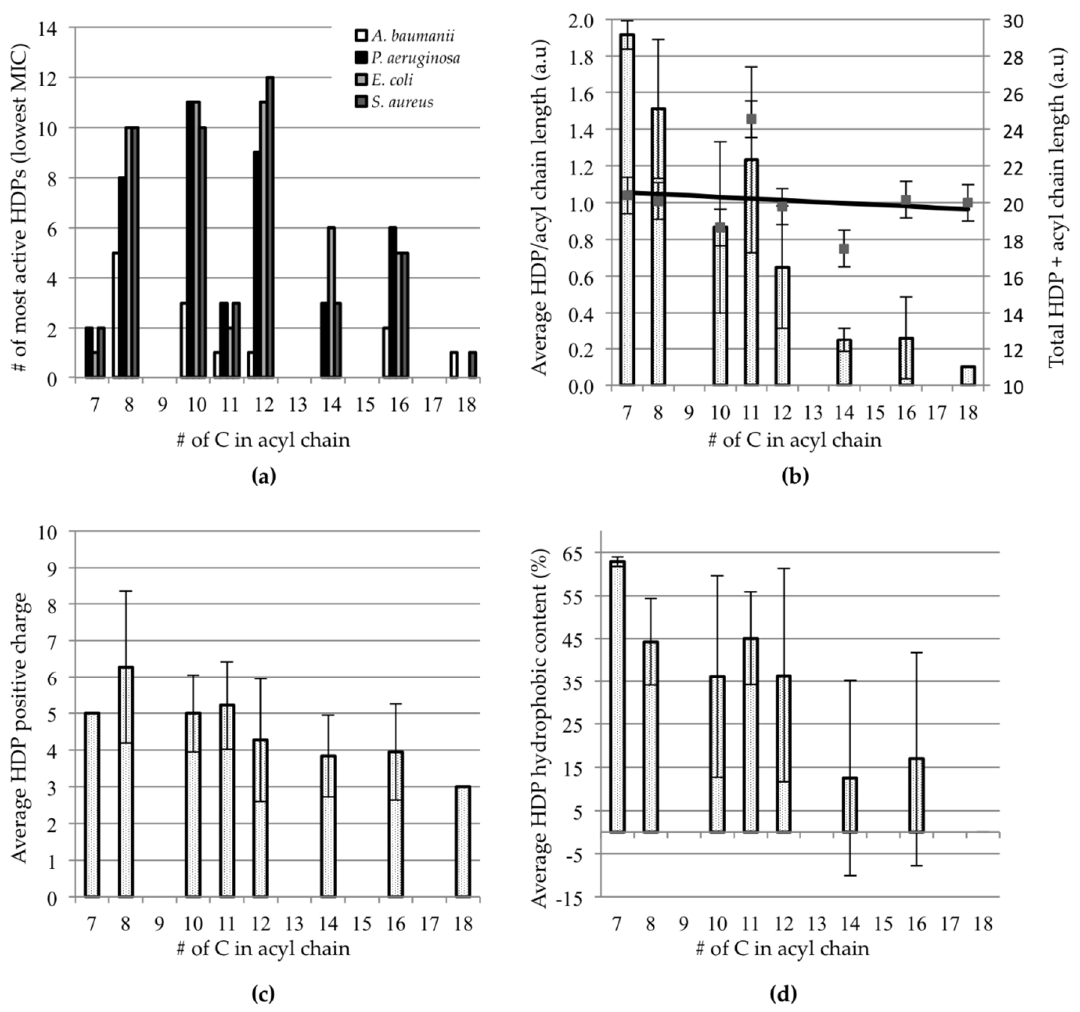
Figure 1. Comparison of lipidated HDPs listed in Table 1 as a function of acyl chain length. ( a ) Number of lipidated HDPs for which a given acyl chain length results in the lowest MIC for 4 di ff erent bacteria; ( b ) average ratio of HDP length and acyl chain length (number of amino acids / number of Cs in the acyl chain)—bars; and total length (squares and fitted line); ( c ) average charge of the parent (nonlipidated) HDP; ( d ) average percent hydrophobic content for the parent HDP. In panel ( b ), a comparison of C8 versus C12 and C8 versus C16 yields p -values < 0.001. For panels ( c , d ), a similar comparison yields p-values that indicate that the di ff erences are not significant.